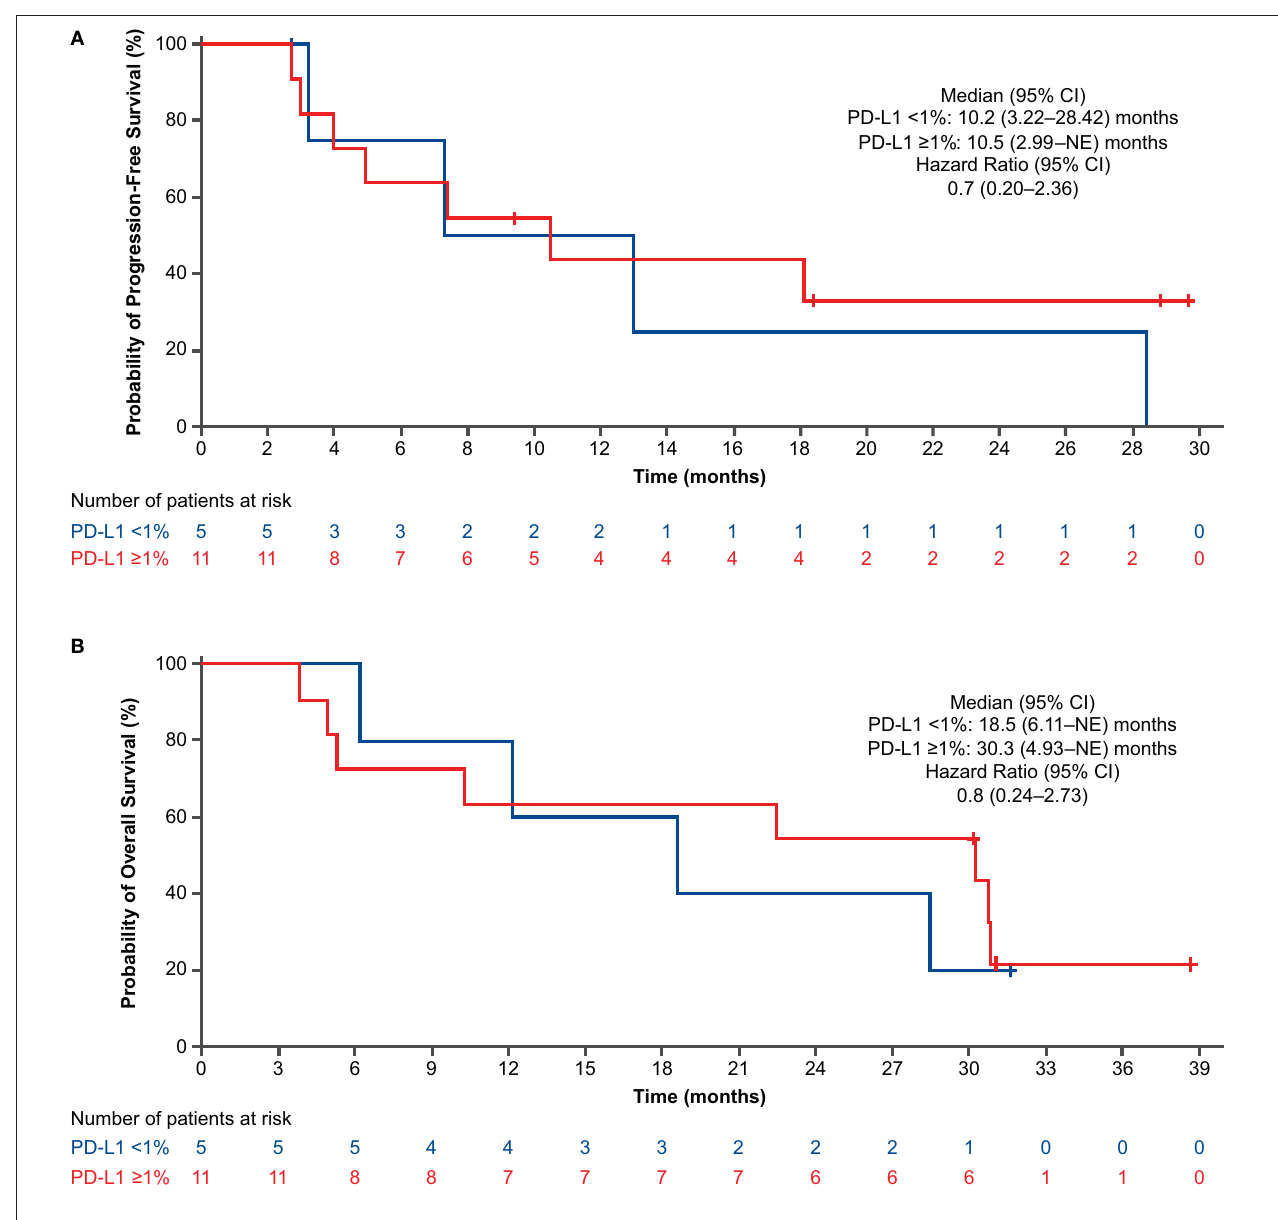
FIGURE 3 | Progression-free survival (A) and overall survival (B) by PD-L1 expression in nivolumab-treated subset (concurrent cohort; dose-finding and expansion parts). CI, confidence interval; NE, not evaluable; PD-L1, programmed death ligand 1.